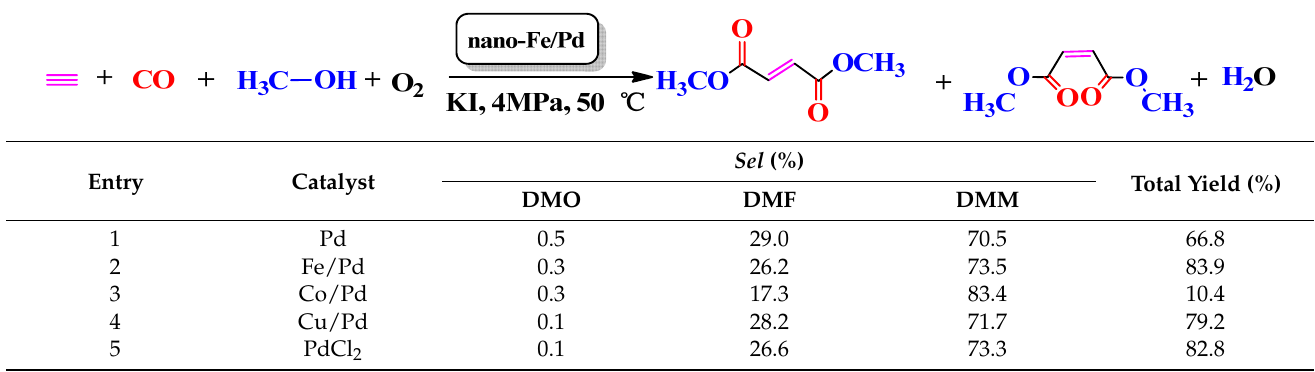
Table 2. Activity comparison of different catalysts for acetylene dicarbonylation.